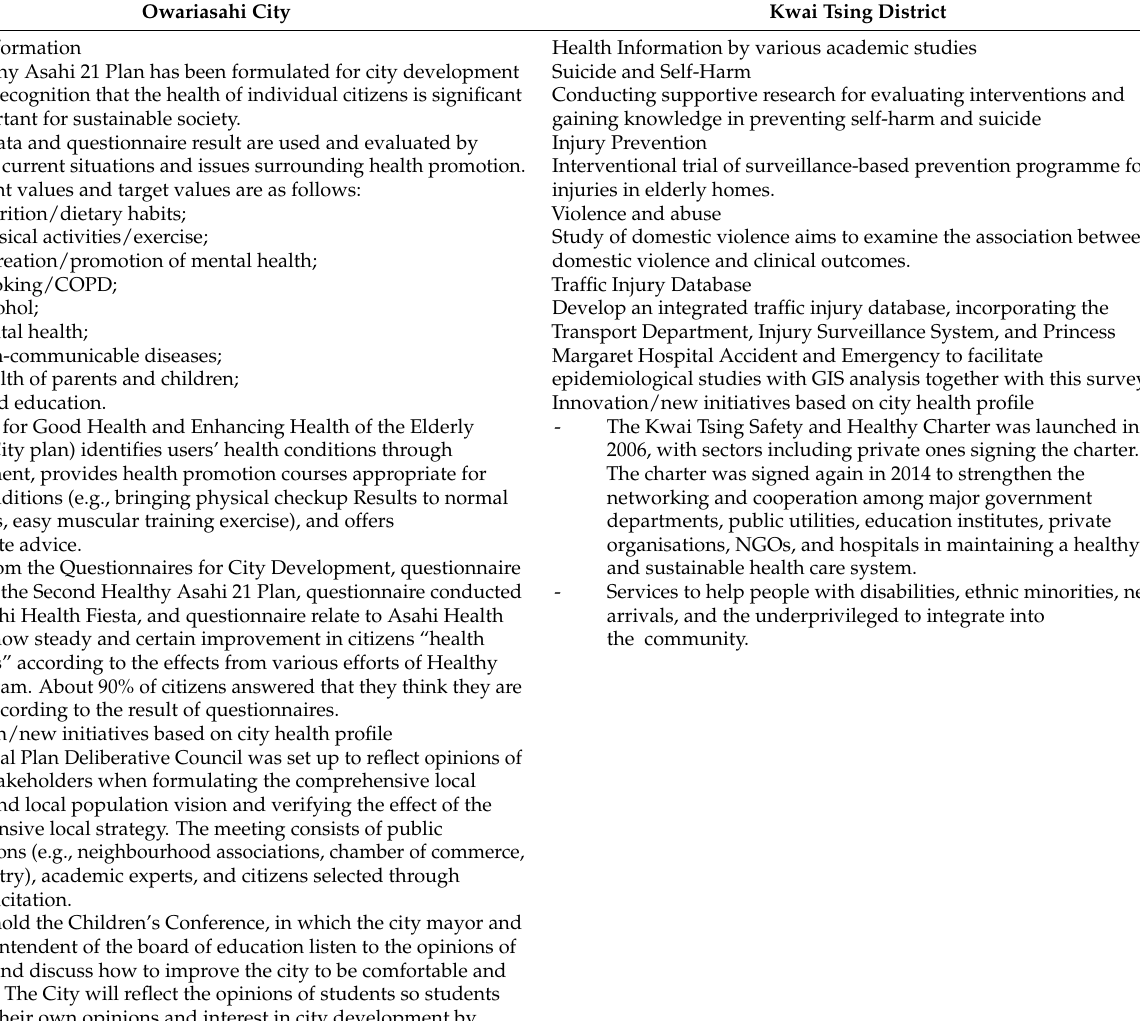
Table 4. Information and